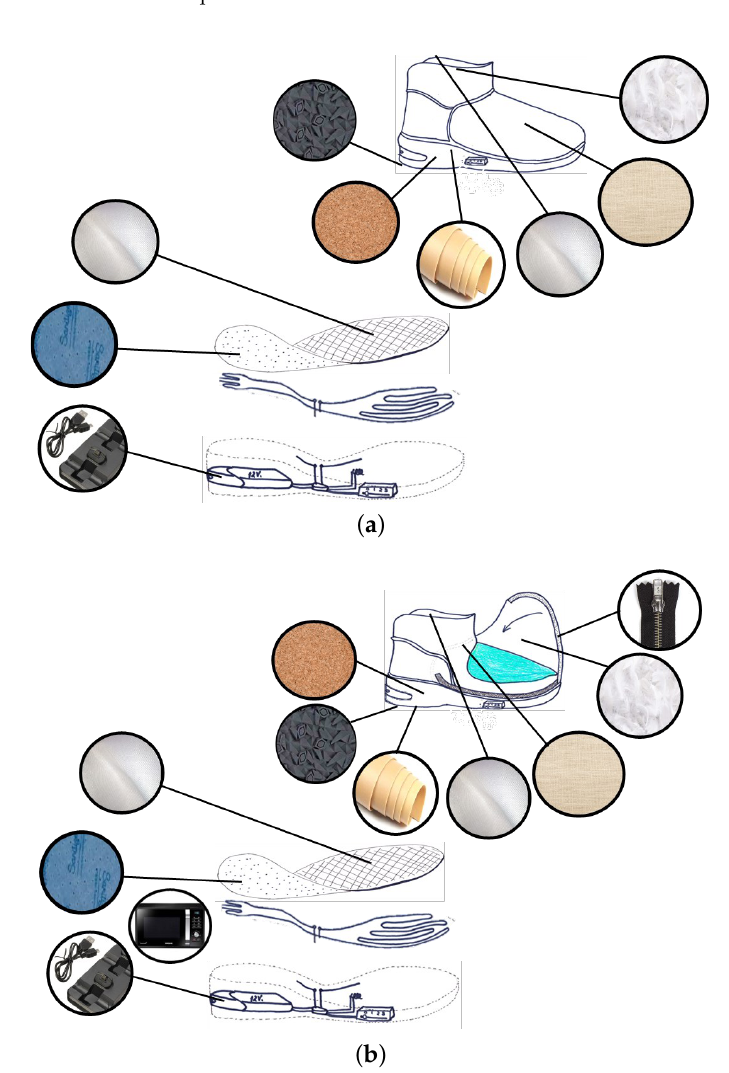
Figure 4. Graphical representation of concepts: ( a ) Star Slipper+ ; ( b ) Diamond Slipper+ . The new set of alternatives was ranked using the approach introduced in Section 5.1. The results are shown in Table 17. The concepts Techno Slipper , Star Slipper+ , and Diamond Slipper+ should be further analyzed and rated using a finer comparison scale. This task is addressed next, in the concept-rating